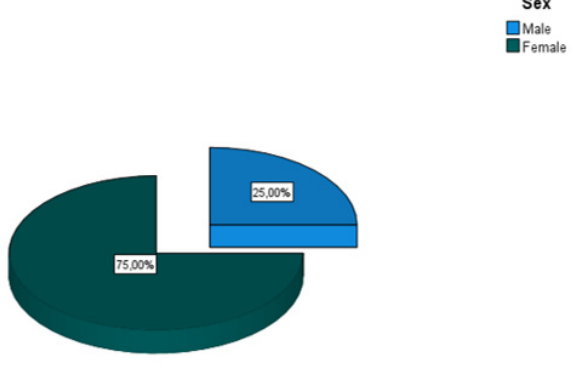
Figure 1. Pie chart presenting the sample’s percentages of male and female primary school